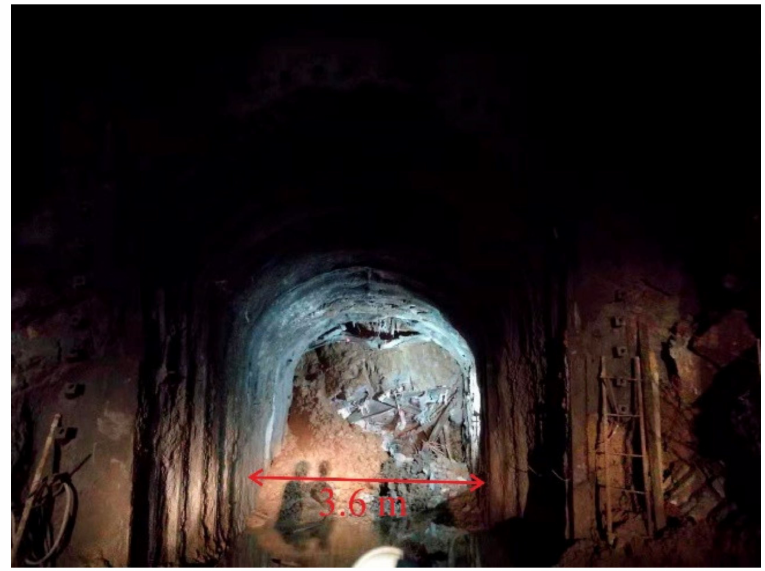
Figure 7. Photo picture of the